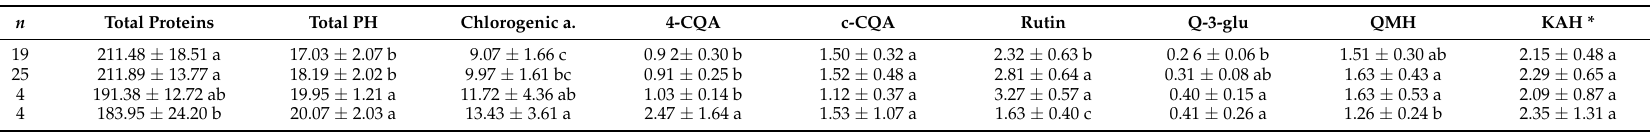
Table 1. Mean concentrations ( ± SD) of the total proteins, total phenolics, and predominant phenolics (mg/g DW) in Slovenian, Hungarian mulberry varieties, reference sericultural varieties, and fruit varieties. Different letters (a–c) indicate significant differences ( p < 0.05) in the concentrations of specific compounds between the analysed groups, as determined by the post hoc Duncan test. n , number of